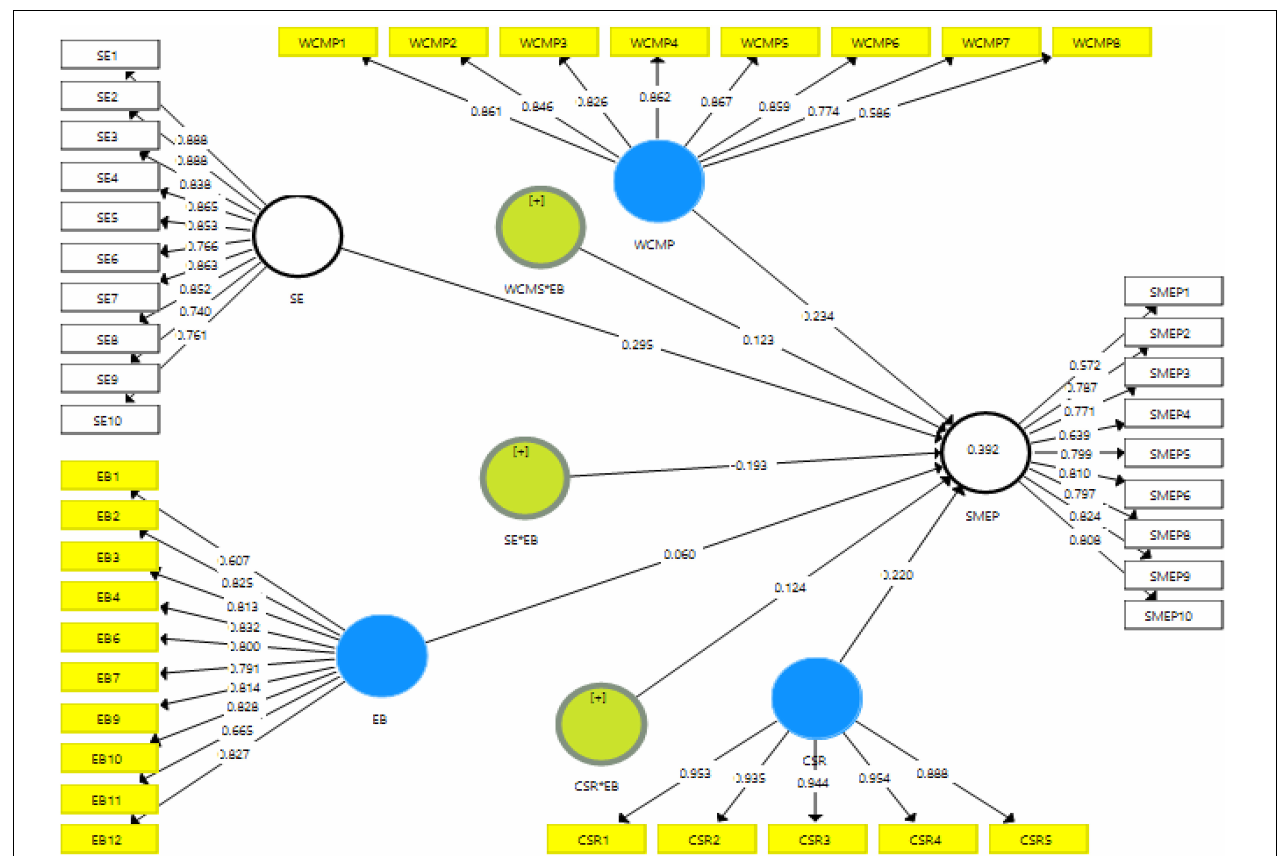
FIGURE 3 | Measurement model